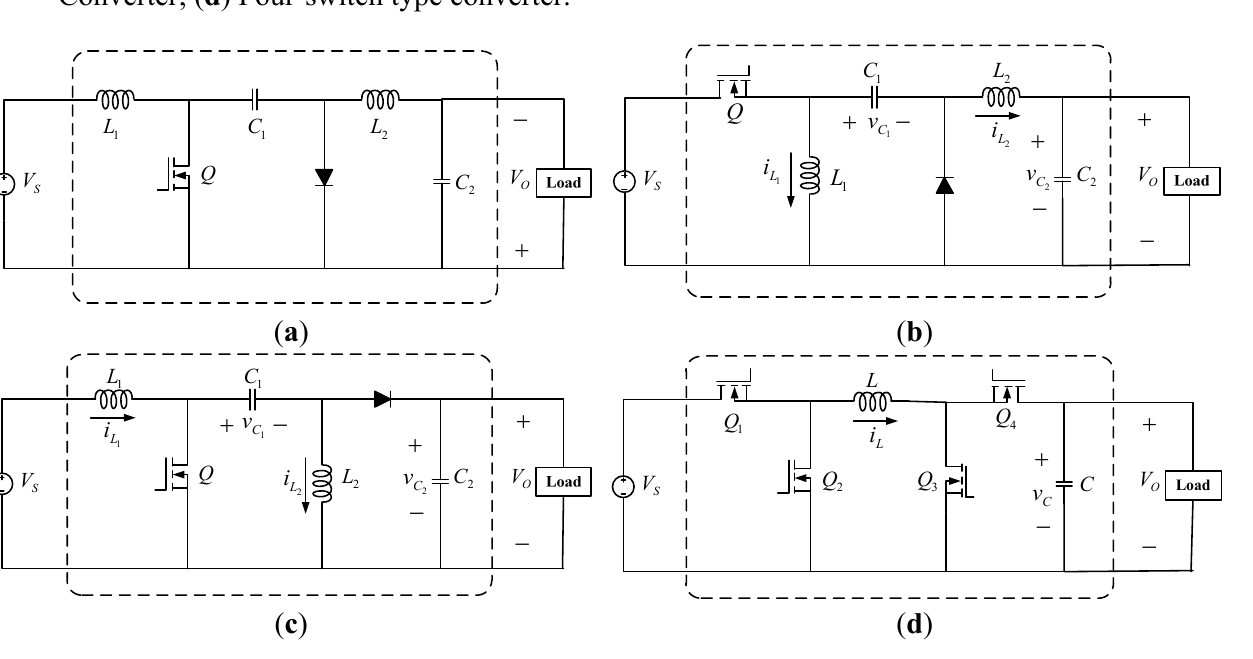
Figure 2. Buck-Boost Converters. ( a ) Cuk converter; ( b ) Zeta Converter; ( c ) SEPIC Converter; ( d ) Four-switch type